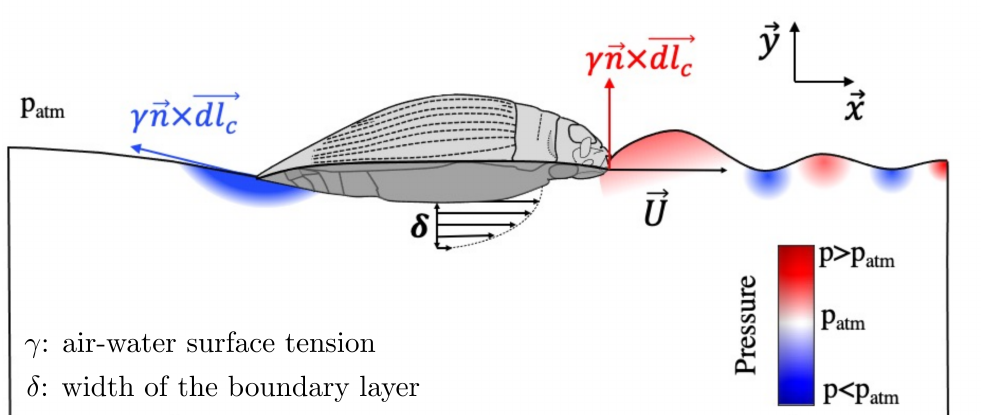
Figure 1. Scheme of the pressure field and the boundary-layer shear flow created by a moving whirligig beetle. Shear flow induces a viscous drag R v on the beetle. Waves generated by the beetle’s movement are associated with an excess pressure field with overpressure (resp. underpressure) in the upper (resp. lower) region of the wave [30], as represented by the blue and red color fields. The pressure field and the local deformation of the interface exert forces on the beetle with horizontal and vertical components. The horizontal resultant corresponds to the wave resistance R w of the beetle. The beetle’s body position is adapted so that the weight is compensated by the vertical resultant and body inclination adapt to cancel the moment of these forces. Hydrostatic pressure (cid:82) p (cid:126) dS i where gradient is disregarded here. Pressure field force on the immersed surface S i reads S i (cid:126) dS i is a vector equal to the element of immersed surface times the unit vector normal to the surface. (cid:82) γ (cid:126) n × (cid:126) dl c where (cid:126) n is the local unit vector Interface deformation force on the contact ligne l c reads l c orthogonal to the interface and (cid:126) dl c is the local element of the contact line oriented